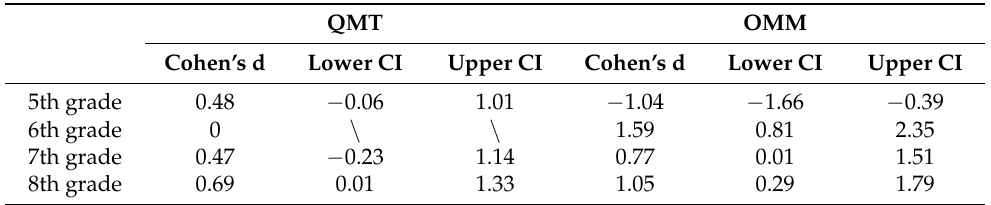
Table 1. Effect size (Cohen’s d) and 95% confidence intervals for ∆ Hits following QMT (left) and OMM (right) in each class.